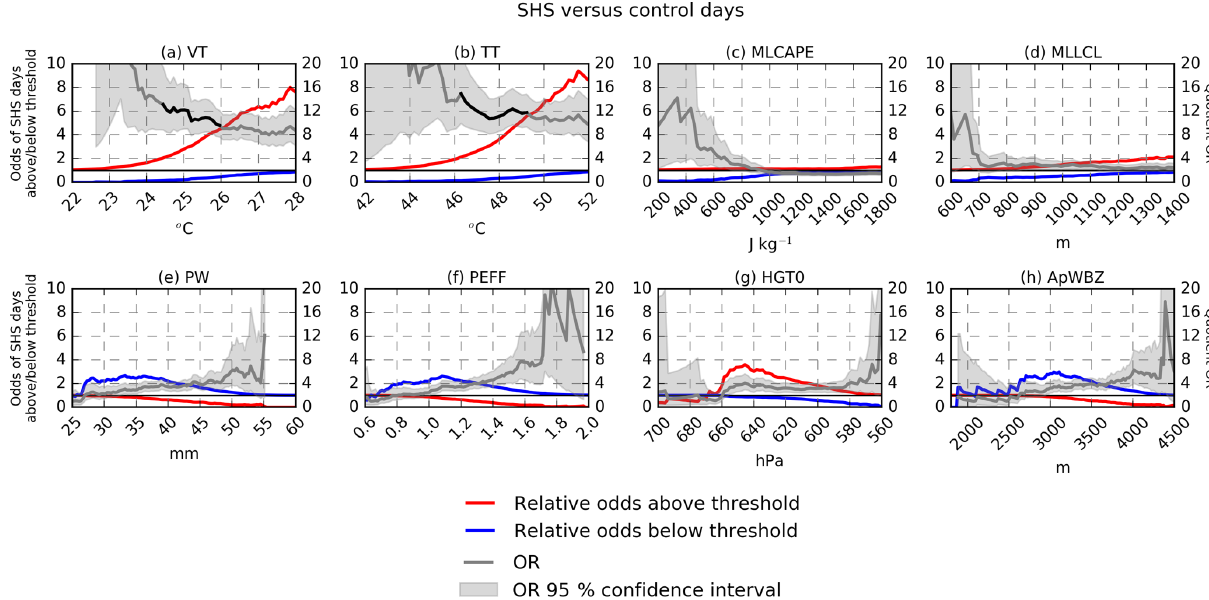
Figure 8. Same as Fig. 6 except for SHS days. Panels (a–d) replicate the same variables shown in Fig. 6, whereas (e–h) are replaced with four SHS-specific parameters from Table 6. At very low and very high threshold values, the variance of the OR may be undefined, and the 95% OR confidence interval cannot be computed.